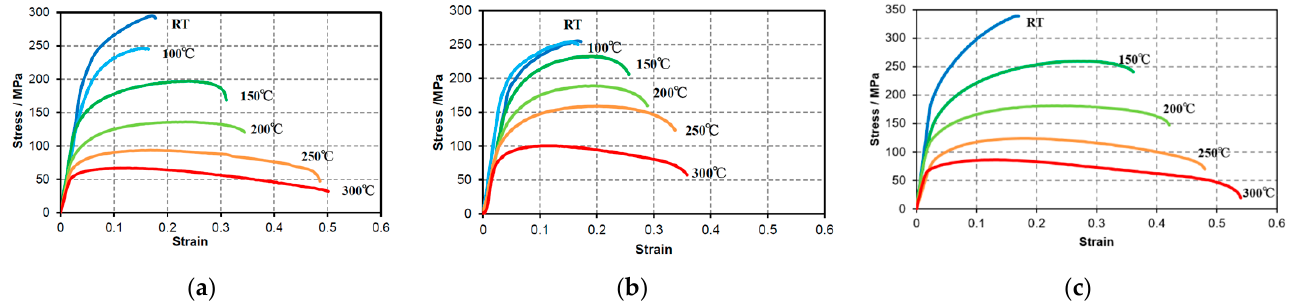
Table 1. Chemical composition of AZ31B and AZ61 magnesium alloy tubes (mass %).